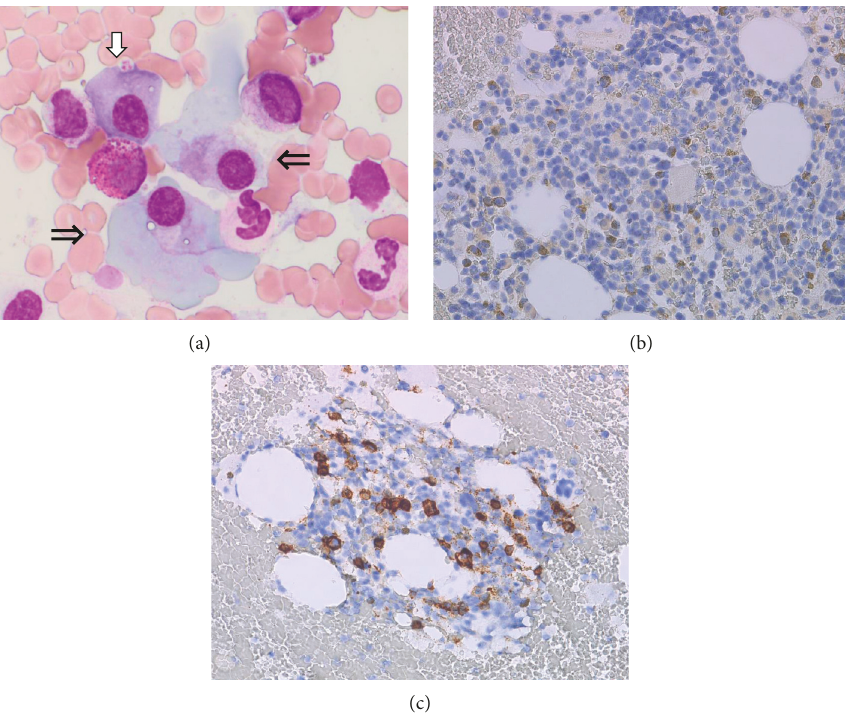
Figure 6: Immunohistochemical staining of bone marrow after R-THPCOP. (a) May Grunwald–Giemsa staining ( × 1000). (b) CD20 ( × 40). (c) CD138 ( × 40). White arrow: normal-sized plasma cell; double arrow: large-sized plasma